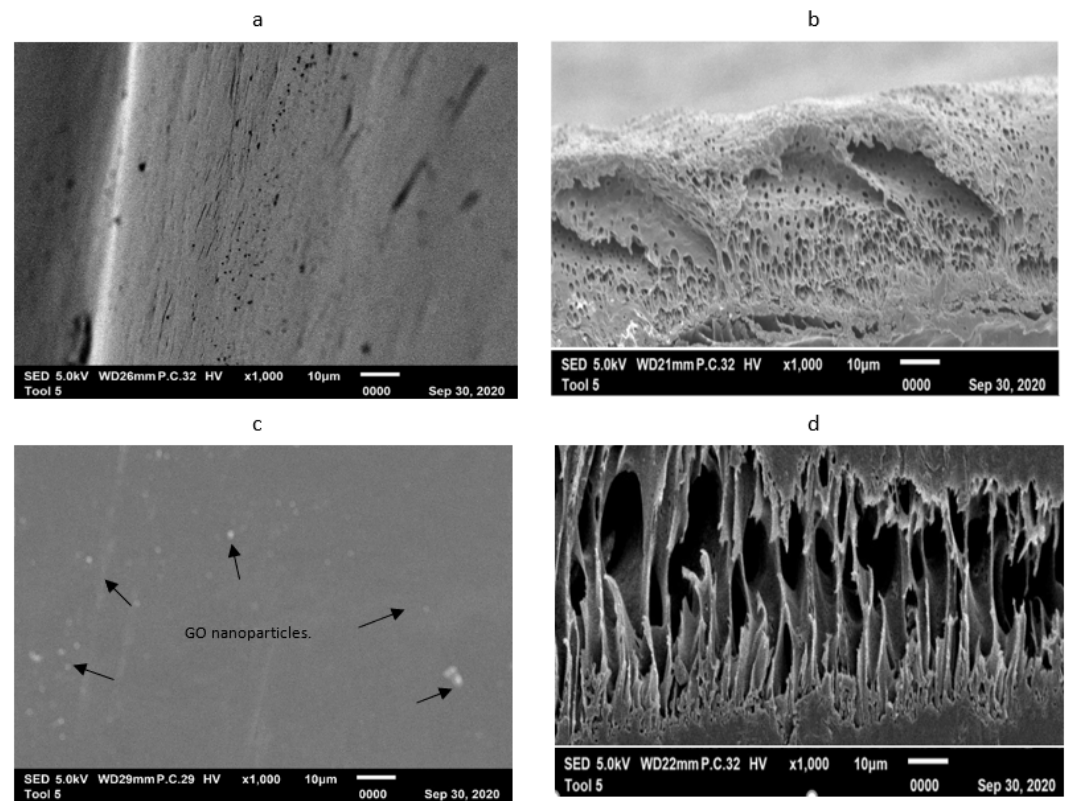
Fig. 5. SEM image of surface and cross-section of (a, b) PES membrane and (c, d) PES-GO-PVP adsorptive membrane. The white dots on the surface of the PES-GO-PVP membrane are the monodispersed GO nanoparticles.